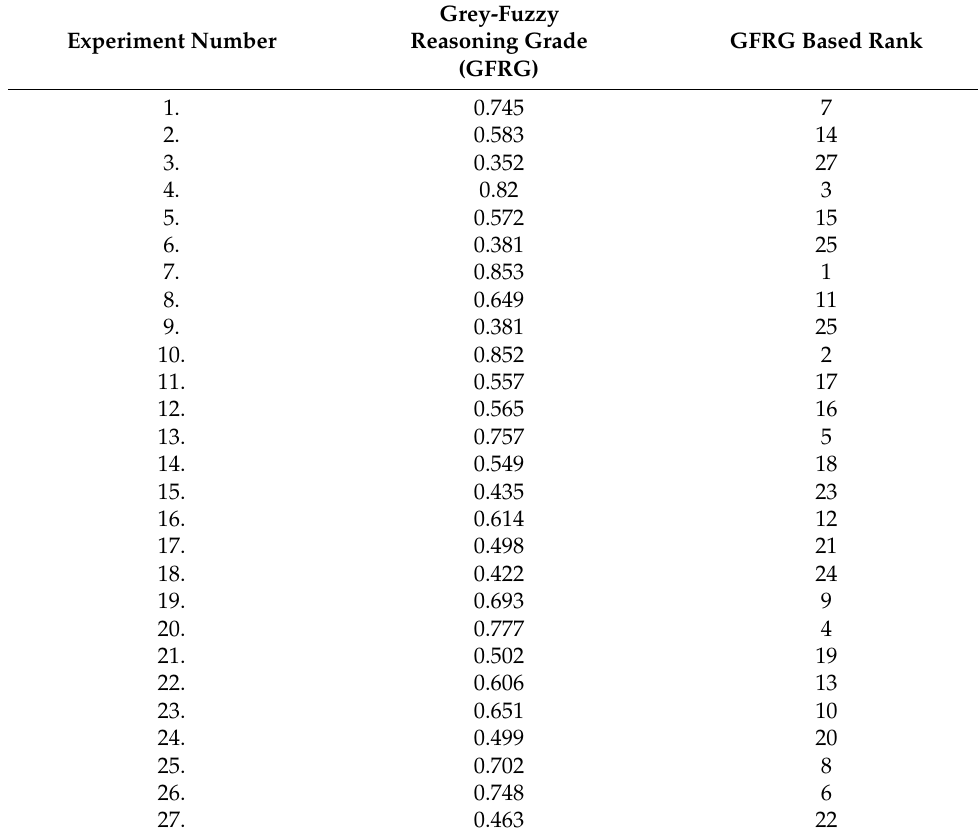
Table 6. Grey-fuzzy reasoning grades (GRFC) and rank.